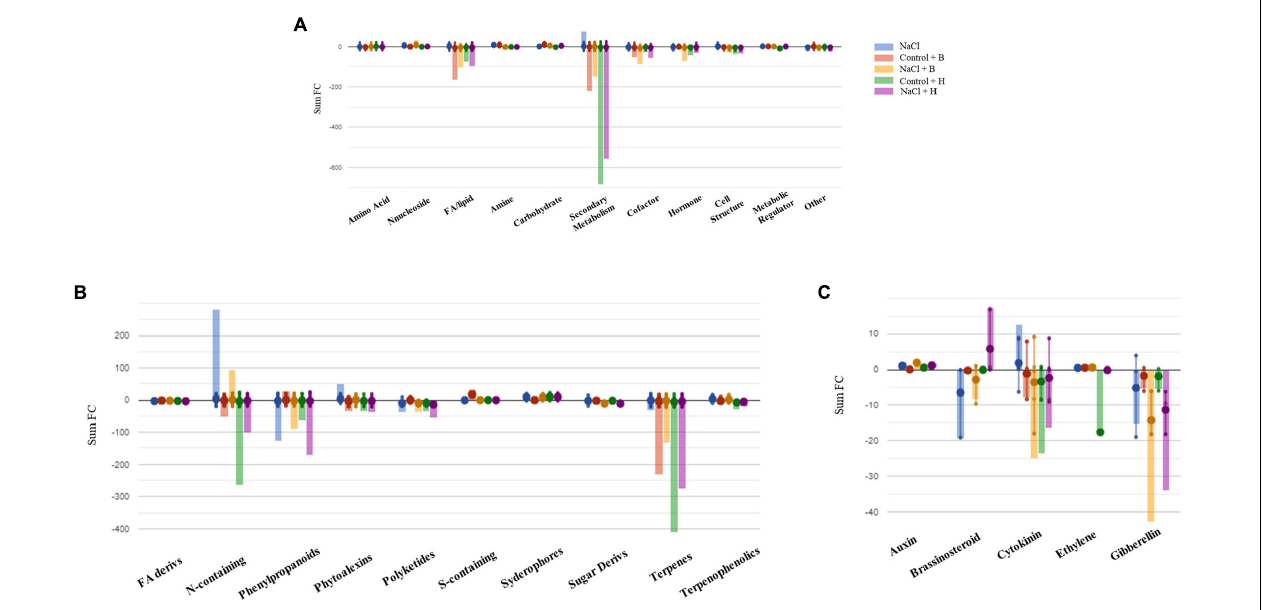
FIGURE 7 | Metabolic changes in lettuce plants. Metabolic processes (A) , secondary metabolism (B) , and (C) hormone biosynthesis were impaired by treatments in lettuce plants compared to control samples. Differential metabolites from the Volcano analysis ( P -value < 0.01, FC ≥ 1.3) were elaborated using the Omics Viewer Dashboard of the Plant Cyc pathway Tool software (www.pmn.plantcyc.com). The large dots represent the average (mean) of all log Fold-change (FC) for metabolites, and the small dots represent the individual log FC for each metabolite. The x -axis represents each set of subcategories, while the y -axis corresponds to the cumulative log FC. FA/Lipid: fatty acids and lipids, Amine: amines and polyamines, Cofactor: cofactors, prosthetic groups, electron carriers, and vitamins, FA Derives: fatty acid derivatives, N-containing: Nitrogen-containing secondary metabolites, S-containing: Sulfur-containing secondary metabolites, Sugar Derives: sugar